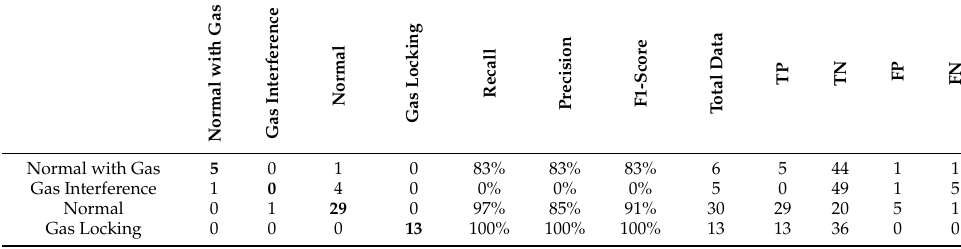
Table 7. Parameters of the Neural Network with hyperparameters and with unbalanced